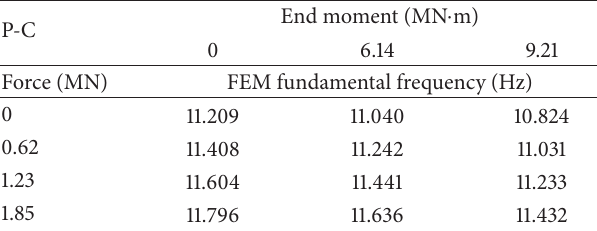
Table 5: Fundamental frequencies for pinned-clamped boundary condition (P-C), when force and end moment are applied; a 40- element FEM model is used.